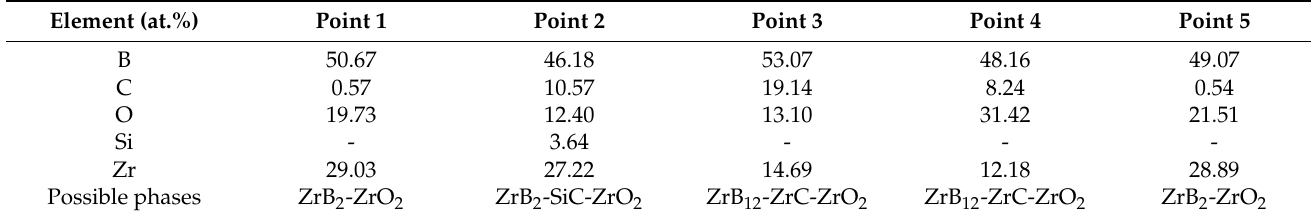
Table 2. EDS results of five positions in Figure 4c.